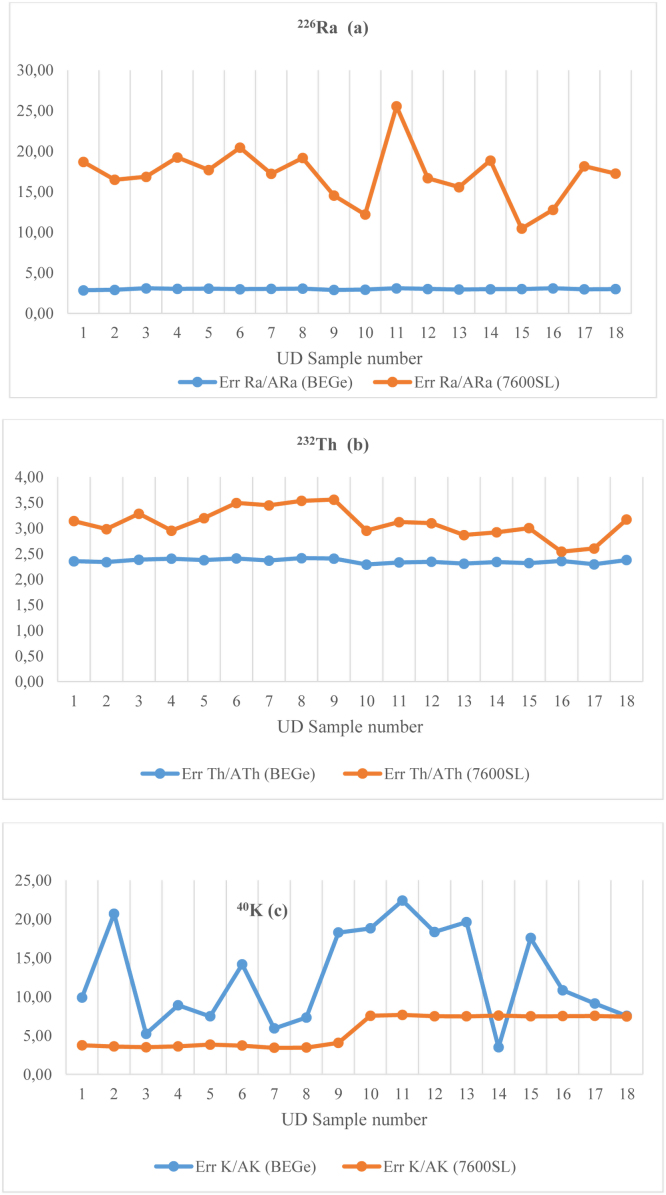
Standard deviation between the two measurements using BEGe-6530 and GC0818-7600SL HPGe detectors: (a) deviation for 226Ra, (b) deviation for 232Th and (c) deviation for 40K.